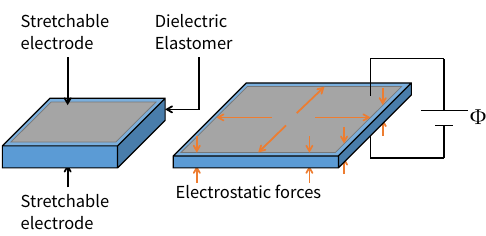
Figure 1. Working principle of a dielectric elastomer transducer (DET). A DET, consisting of a thin film of dielectric elastomer coated with stretchable electrodes, softens when a constant voltage Φ is applied across its electrodes due to electrostatic forces that tend to expand it in area and compress it in